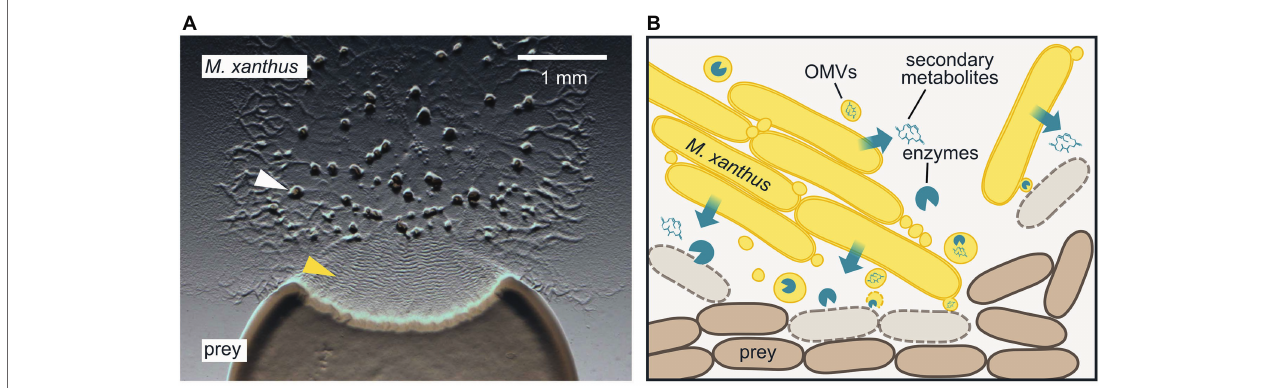
FIGURE 1 | Epibiotic predation by the myxobacterium Myxococcus xanthus . (A) M. xanthus cells that are placed next to E. coli on a CF agar plate, which only provides a minimal amount of nutrients, expand radially using gliding motility, enter the prey colony, and lyse prey cells. Multicellular fruiting bodies (white arrowhead), in which M. xanthus cells differentiate into spores, start to emerge near the inoculation spot. Preying M. xanthus induces regular cell reversals, which appear as macroscopic ripples within the prey area (yellow arrowhead). The image was taken 2 days after the initial inoculation of predator and prey. (B) M. xanthus secretes hydrolytic enzymes and secondary metabolites, which presumably kill and degrade prey cells for biomass acquisition. Outer membrane vesicles (OMVs) may contribute to the delivery of these lytic factors. M. xanthus cells typically move and prey in large clusters, but also individual cells are able to induce prey cell